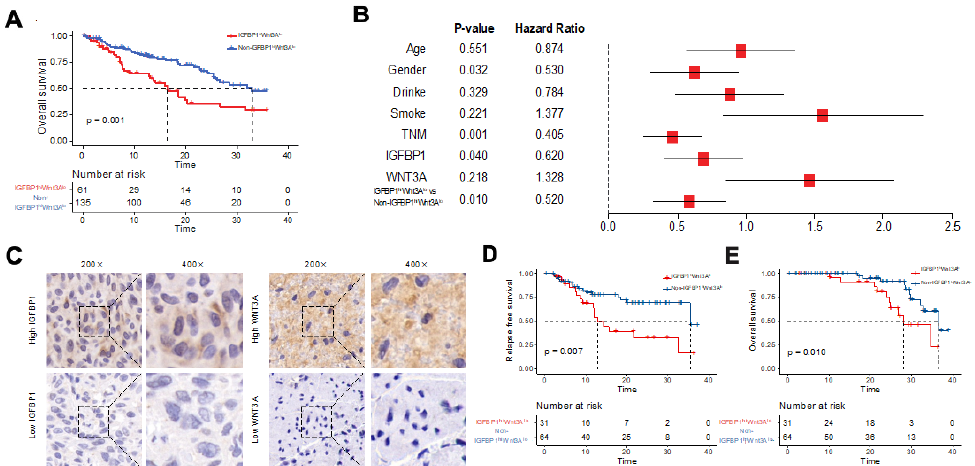
Figure 4. Relationship between the IGFBP1 hi WNT3A lo signature and prognosis of esophageal cancer. ( A ) Kaplan–Meier survival curve of OS in the cohort from TCGA; ( B ) forest plot showing the results of multifactorial Cox regression analysis the cohort from TCGA. The entry method was For- ward:LR; ( C ) representative IHC for IGFBP1 and WNT3A; ( D ) Kaplan–Meier survival curve of RFS in the BJCH cohort; ( E ) Kaplan–Meier survival curve of OS in the BJCH cohort.